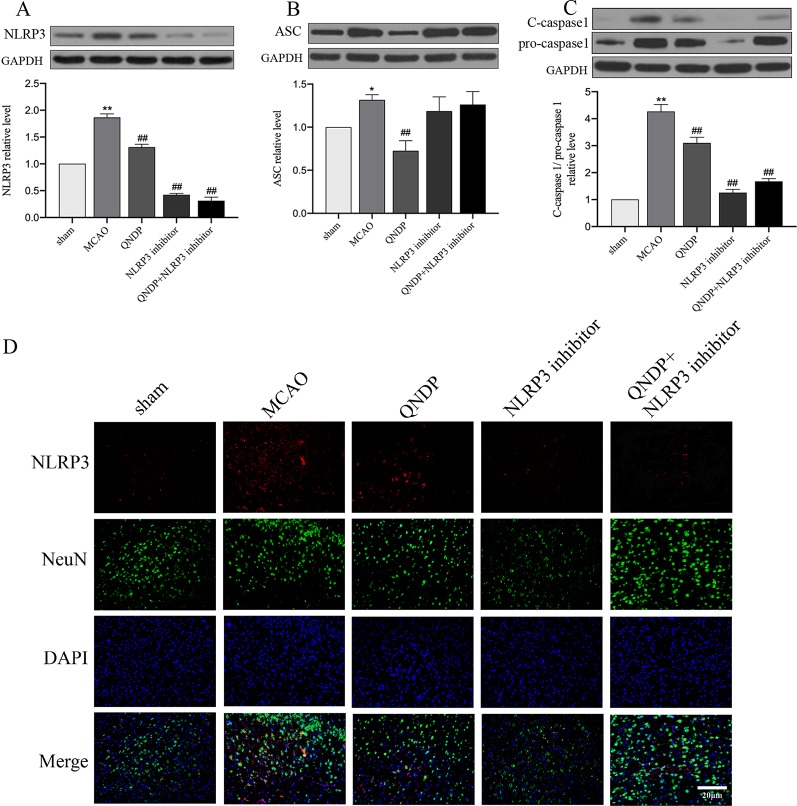
Effect of QNDP on the expression of NLRP3, ASC, and cleaved caspase 1/pro-caspase 1 in MCAO rats. (A) Western blotting analysis of NLRP3, (B) Western blotting analysis of ASC, (C) Western blotting analysis of C-caspase 1/pro-caspase 1, (D) Immunofluorescent staining for NLRP3 (red), NeuN (green), the nuclei were stained blue with DAPI. Scale bar indicates 20 μm. Data are presented as the mean ± SEM, n = 3 per group, *p < 0.05, **p < 0.01 compared with the sham group, ##
p < 0.01 compared with the MCAO group.